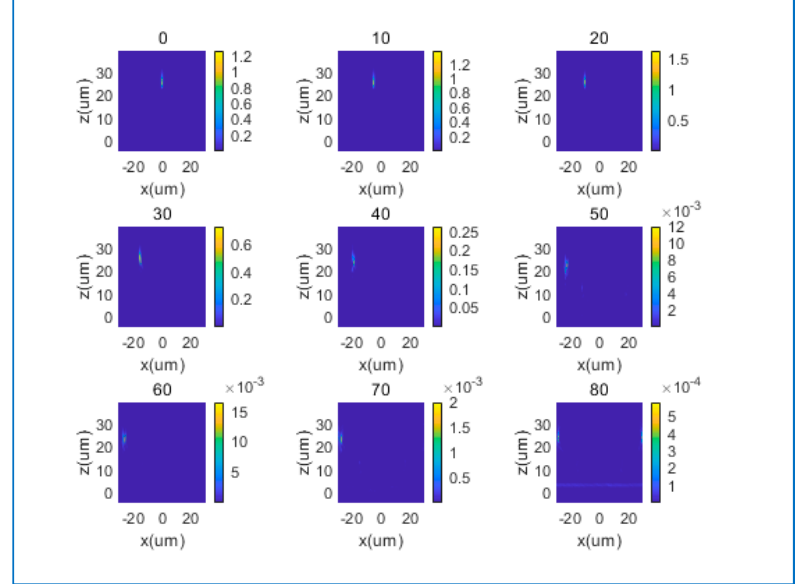
Figure A2. Focal profile of light with incident angles from 0° to 80°, which is reflected by the meta-reflector with DBR as bottom mirror in Figure 4a.